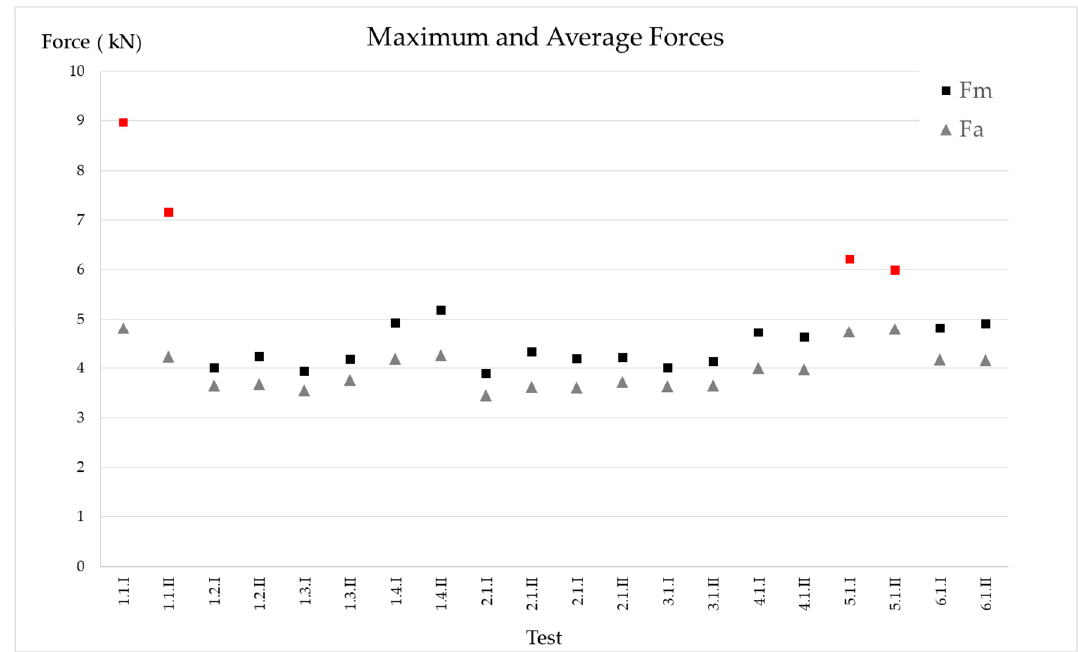
Figure 9. Average and maximum arrest forces.